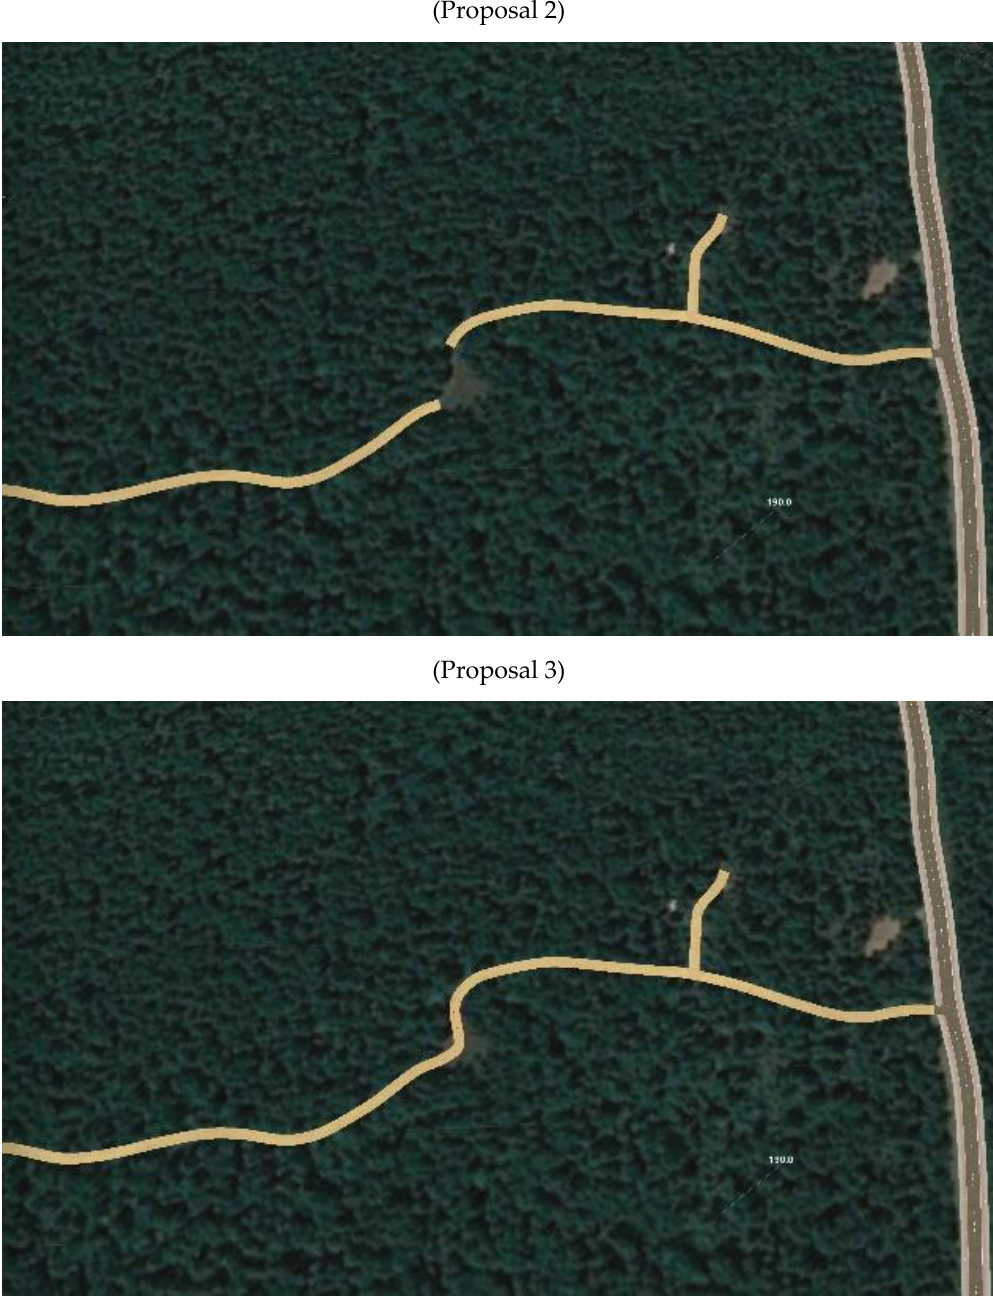
Figure 13. Correction of a sudden interruption of the road caused by an enlarged area with less vegetation.